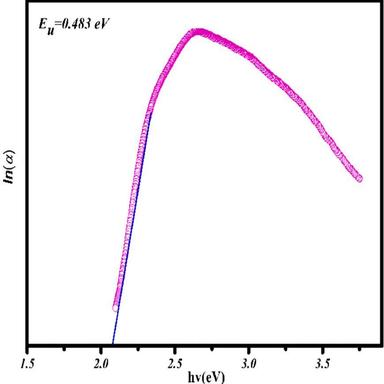
lnα vs hv for the determination of Eu.